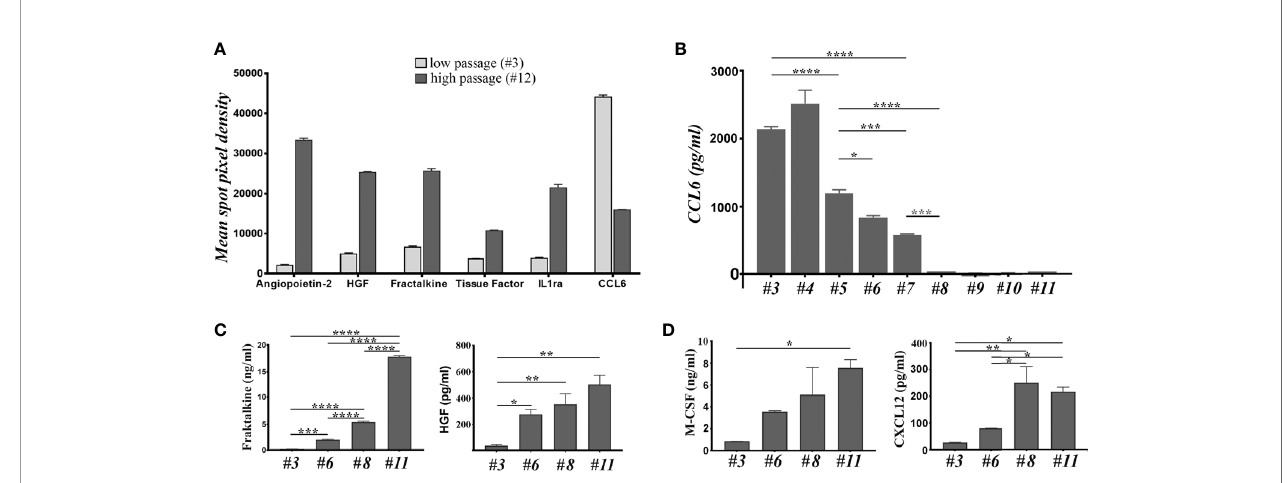
FIGURE 3 | The analysis of soluble factors secreted by cells at low and high passages. ( A) The relative expression level of 6 cytokines identi fi ed by cytokine array in the secretome of cells at 3 versus # 12. The depicted cytokines were selected from the 111 soluble proteins detected by cytokine array based on two considerations: a high level of expression and high differences between the two passages. (B) ELISA quanti fi cation of CCL-6 in the secretome of cells at increasing passages. Note the high level of CCL-6 at low passages and its loss after passage 7. The data represent the results of one representative experiment from 5 experiments with different batches and similar conclusions. (C) ELISA quanti fi cation of Fractalkine and HGF in the secretome of cells at different passages. The data represent the mean+/- S.D. @ of at least 3 experiments performed in duplicates. Note that Fractalkine is secreted by cell culture at all passages, while HGF is completely absent from the culture at low passage. (D) The LegendPlex quanti fi cation of M-CSF and CXCL12 in the secretome of cell culture at different passages. Data illustrates one experiment performed in duplicates. Two independent experiments with different batches were analyzed and the results were similar. *p < 0.05, **p < 0.01, ***p < 0.005, ****p <